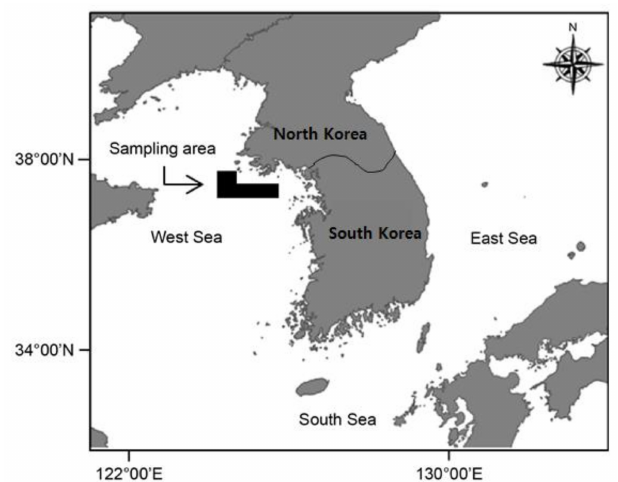
Figure 2. Location of the ocellate spot skate Okamejei kenojei sampling area in the present